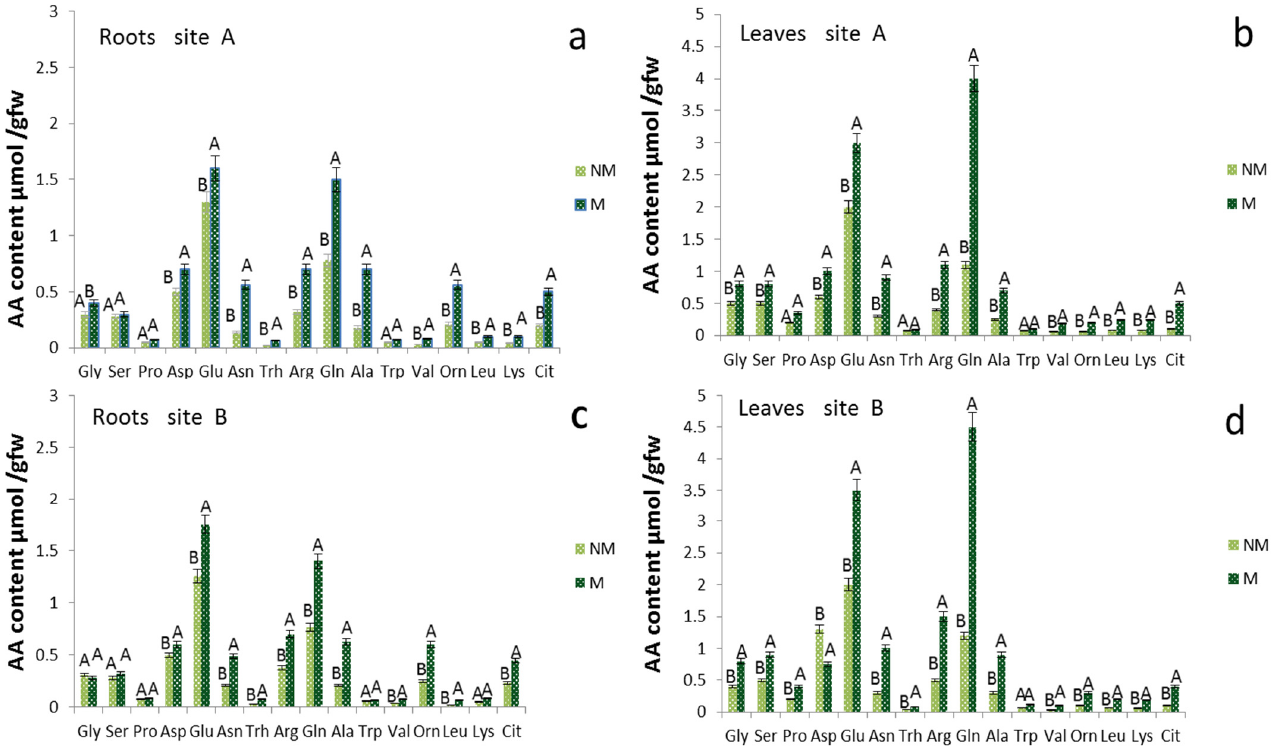
Figure 3. Amino acid concentrations of roots and leaves tissue of Triticum durum of control (NM) and mycorrhizal (M) treatments 190 d after sowing in two different soil sites (A and B; ( a , c ) refer to the roots, while ( b , d ) to the leaves). The values are means ± SD of ten plants ( n = 10) in each experimental parcel. Bars indicate the standard deviation. Values marked by common letters are not statistically different at p ≤ 5% according to Tukey’s test.